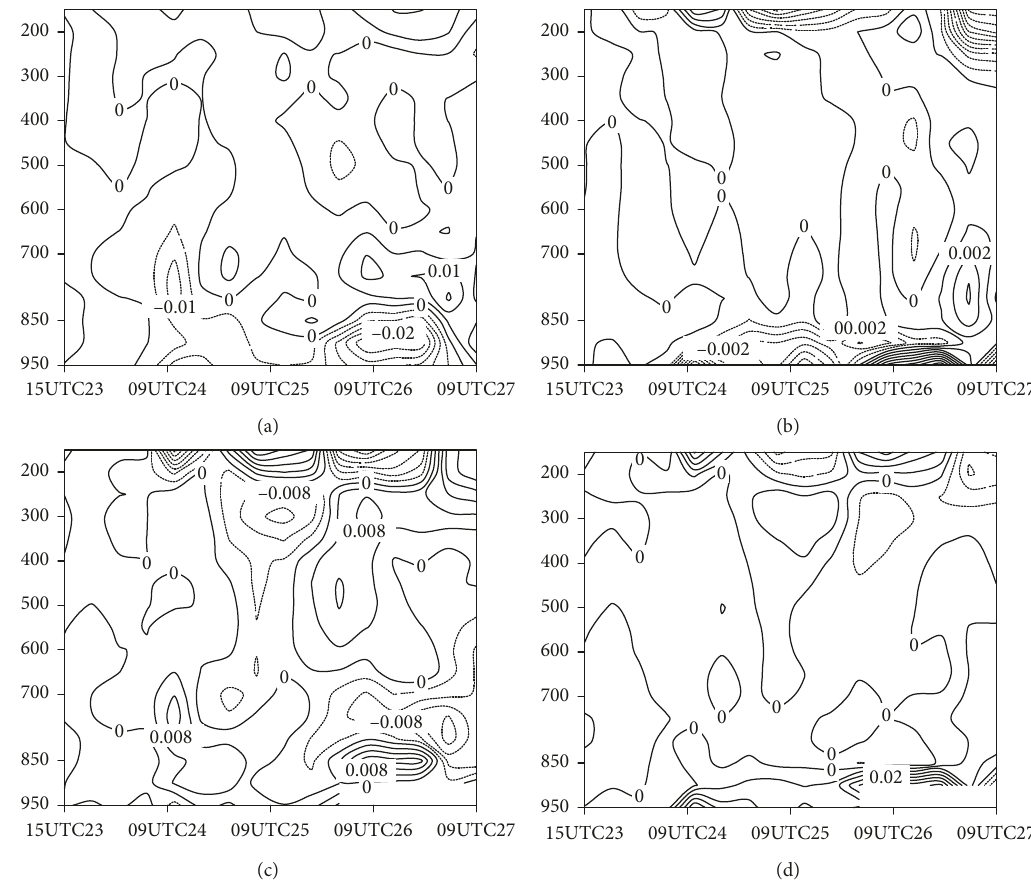
Figure 11: Height-time sections of kinetic energy budget terms (unit: m 2 s − 3 ): generation kinetic energy (a), horizontal flux of kinetic energy (b), vertical flux of kinetic energy (c), and kinetic energy dissipation (d) from 1500 UTC 23 August to 0900 UTC 27